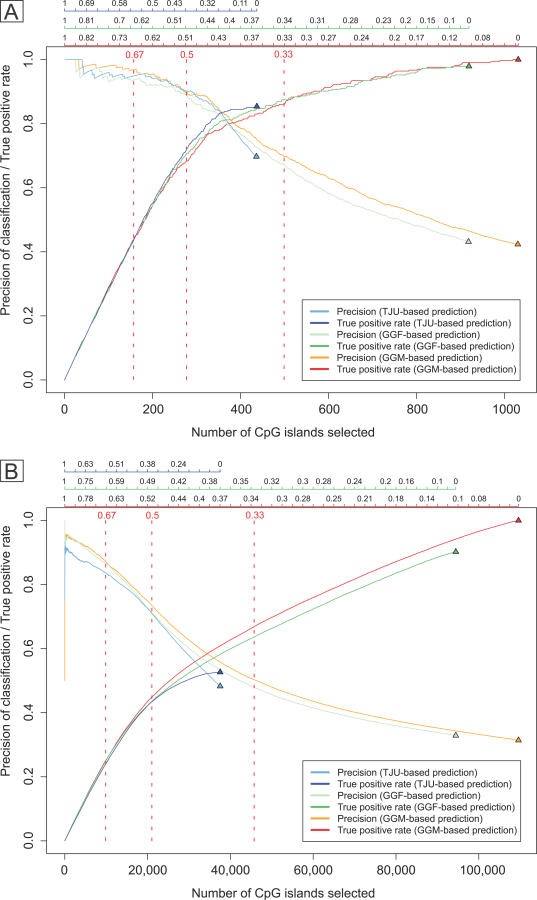
Performance of the Combined Epigenetic Score Compared between CpG Island Maps That Use Different Repeat-Exclusion StrategiesThis figure plots the precision (i.e., the percentage of experimentally supported bona fide CpG islands among all selected CpG islands) and the true positive rate (i.e., the percentage of experimentally supported bona fide CpG islands that are selected) over the total number of cases predicted as bona fide CpG islands, for any valid threshold on the combined epigenetic score. Evaluation criteria are absence of DNA methylation (A) and presence of promoter activity as indicated by experimentally determined transcription start sites (B). The three scales on top of each plot display the score thresholds that correspond to the number of CpG islands selected. Dashed lines show the three thresholds that were used to derive the final bona fide CpG island maps on the basis of the GGM dataset. Numbers on the x-axis are significantly lower in (A) than in (B) because of the fact that the DNA methylation dataset covers only a random sample of unmethylated and methylated CpG islands, while the promoter activity dataset covers essentially all nonrepetitive CpG islands genome-wide.